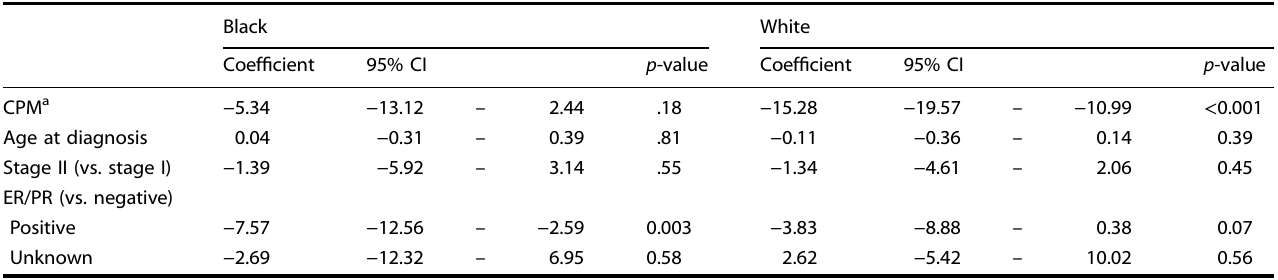
Table 4. Linear regression models for patient risk perception of a second breast cancer by race ( N =